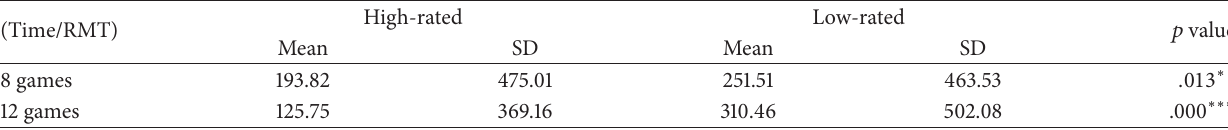
Table 2: Descriptive statistics and empirical